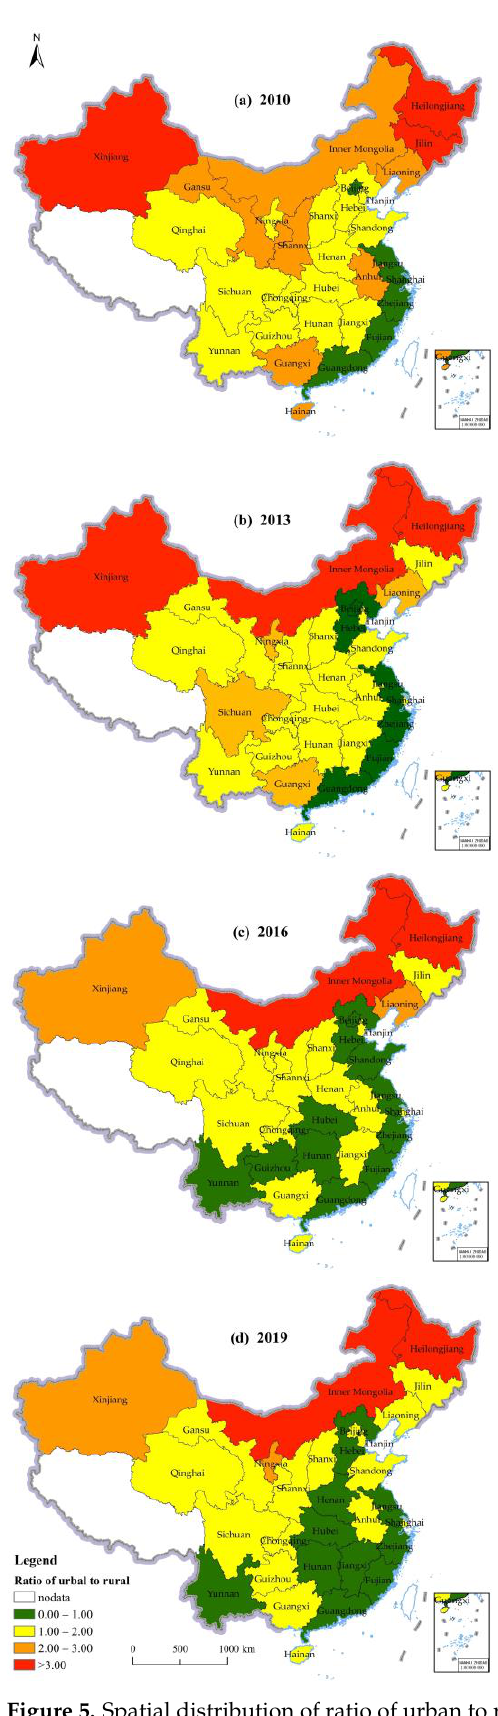
Figure 5. Spatial distribution of ratio of urban to rural per capita RCE in China in 2010 ( a ), 2013 ( b ), 2016 ( c ), and 2019 ( d ).